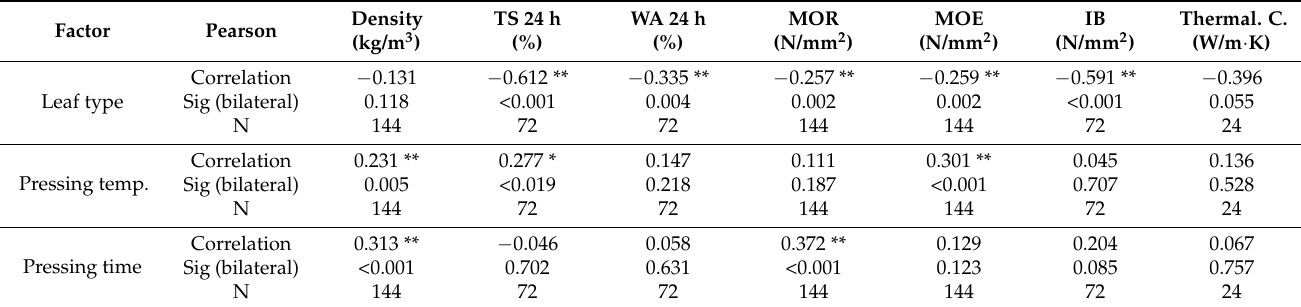
Table 4. Pearson correlation of the results of the